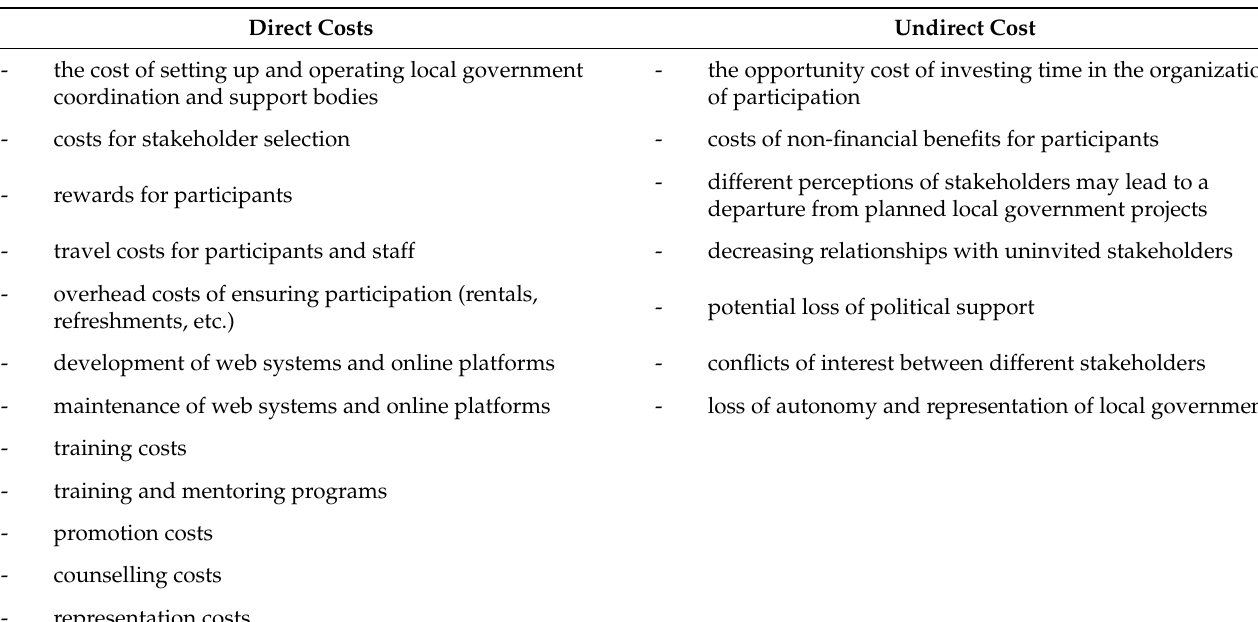
Table 4. Direct and indirect costs of local governments from